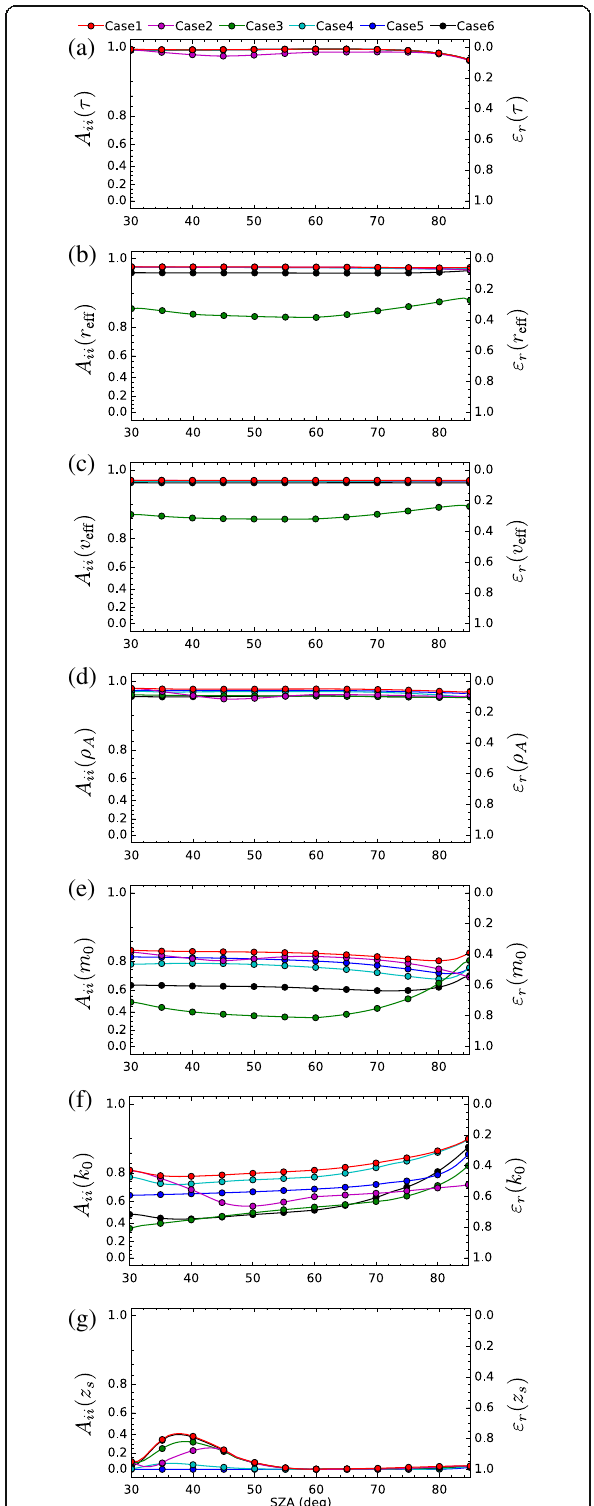
Fig. 7 Diagonal elements of AKM and error ratio of dust model parameters. The left and right scales are for AKM and error ratio, respectively. Case 1, with all observation parameters listed in Table 5; case 2, without DSR; case 3, without aureole; case 4, without forward scattering; case 5 without backward scattering; and case 6, without color ratio. Averaging kernel closer to unity means that information from observations is more significant. Panels ( a ) - ( g ) show the relation between A ii / ε r , i and SZA for X 1 - X 7 ,